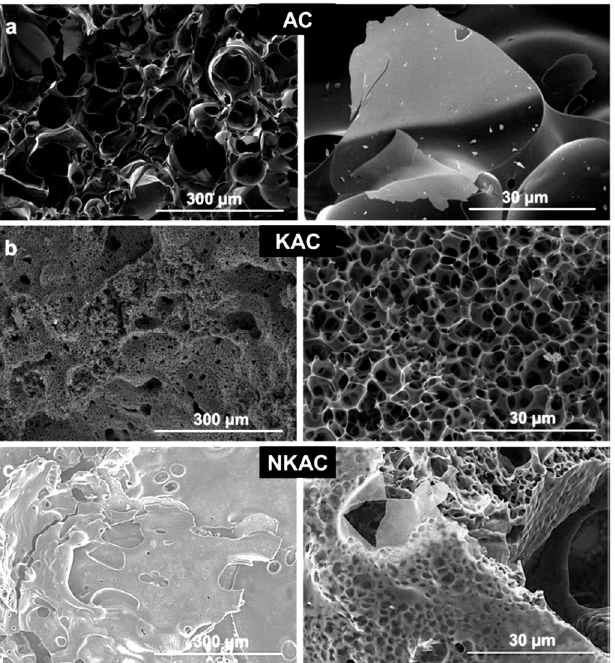
Figure 4. SEM images of agar aerogel ( a ), KOH ‐ treated agar aerogel ( b ), and urea/KOH ‐ treated agar aerogel ( c ) [54]. aerogel ( c )